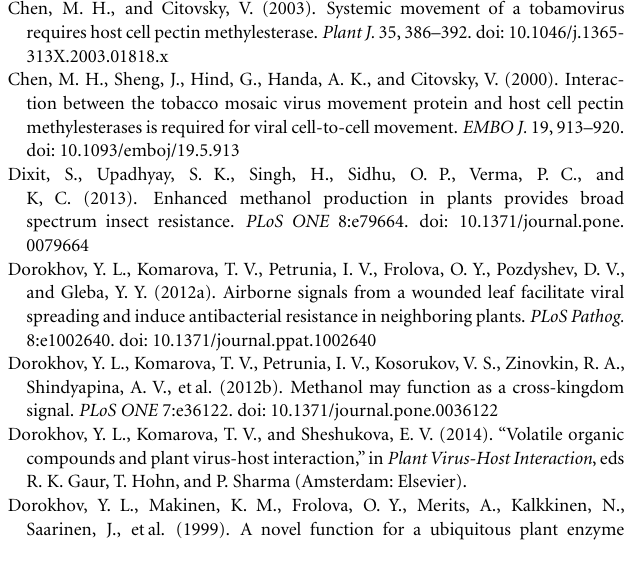
and neighboring plants, including activation of the MIGs (4), the emergence of bacterial immunity (5), the opening of plasmodesmata, and increased sensitivity to the virus penetration and intercellular distribution of viral pathogens